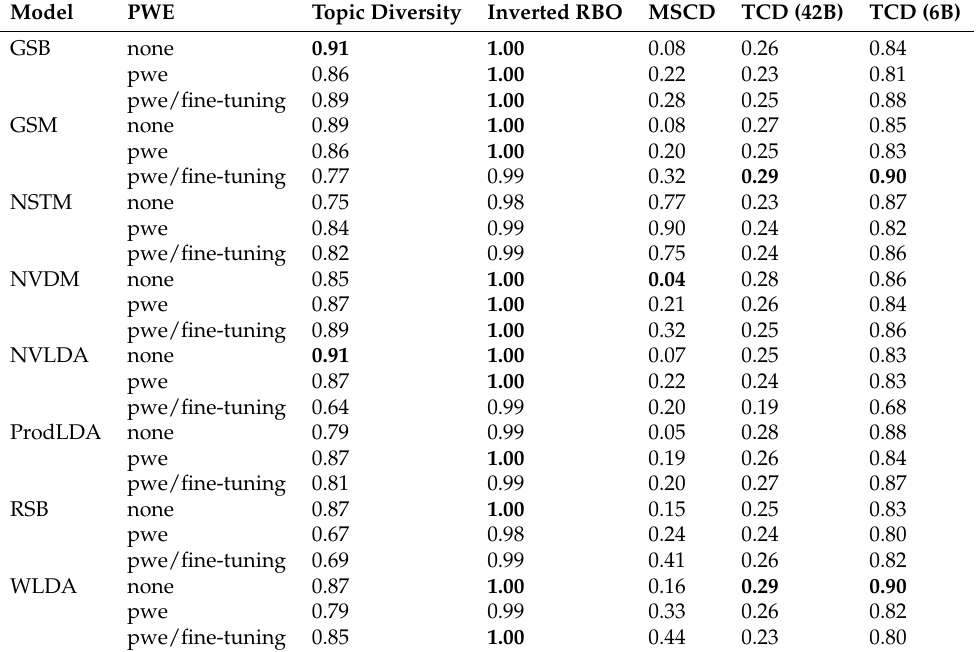
Table 18. Topic Diversity on M10.